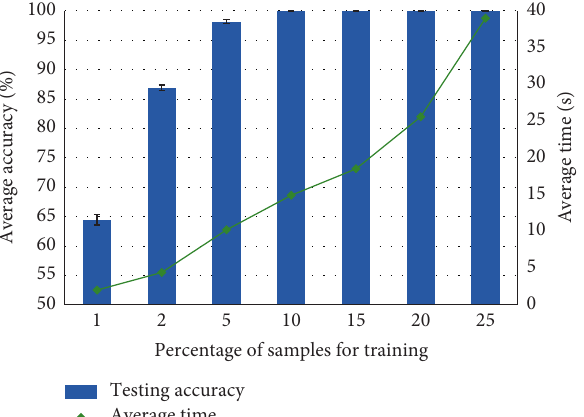
Figure 7: The diagnosis results of the DSF method using different percentage of training samples.